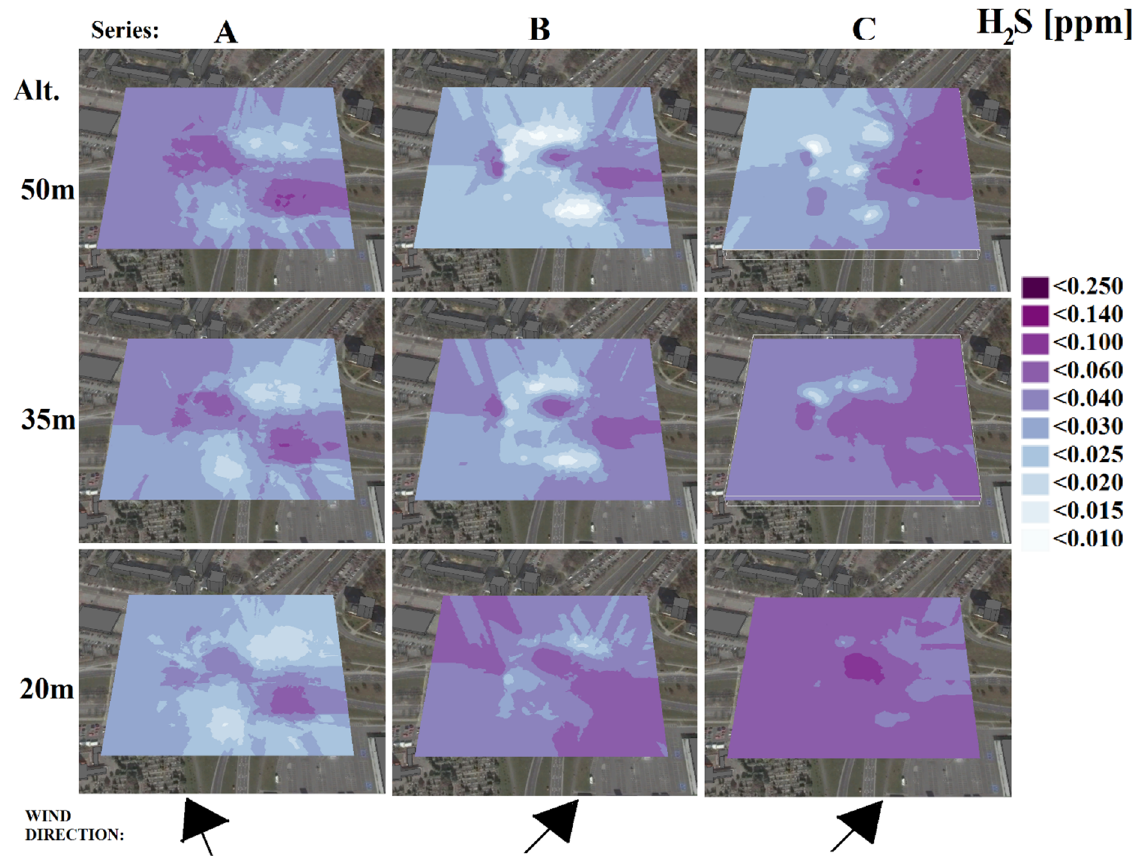
Figure 12. Spatial distribution of H 2 S pollution at the altitude of 20, 35, and 50 m for three measurement series in the area of the street intersection.